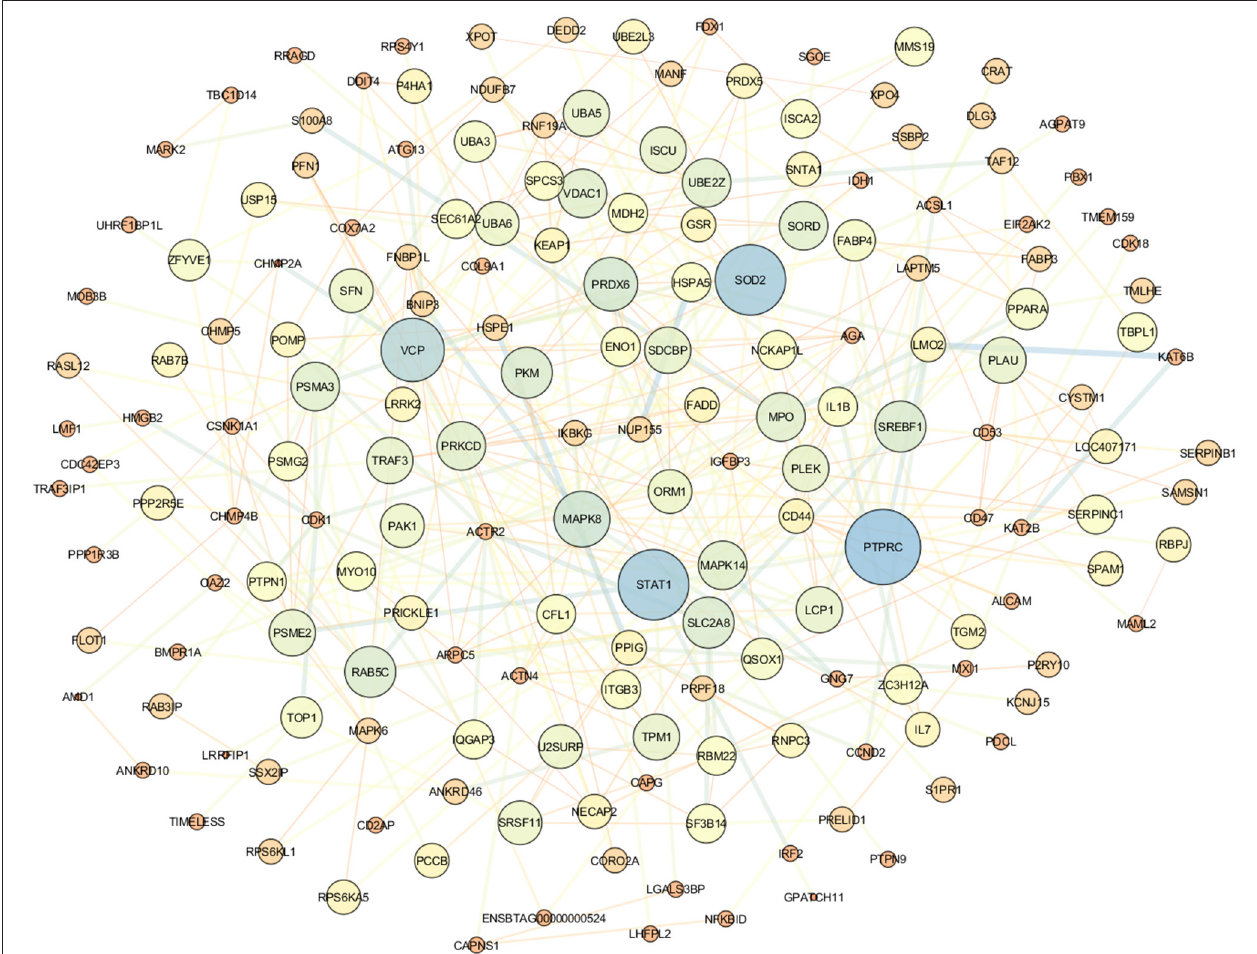
FIGURE 5 | Protein–protein interaction network for the common genes using